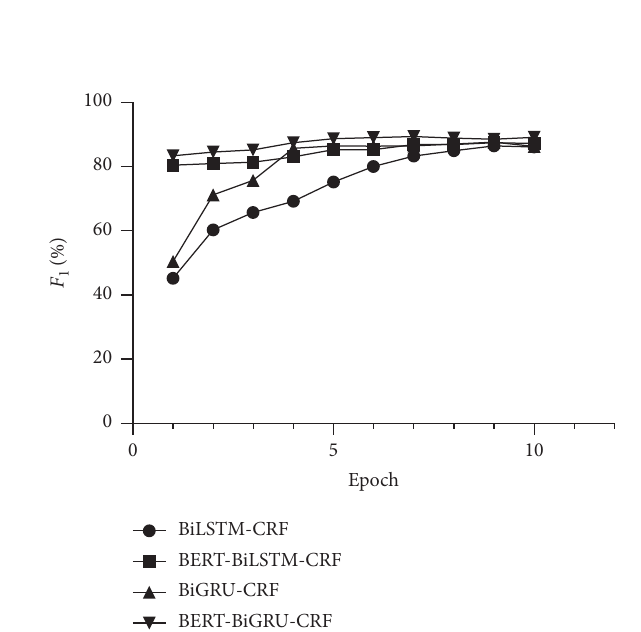
Figure 6: Comparison of entity F 1.